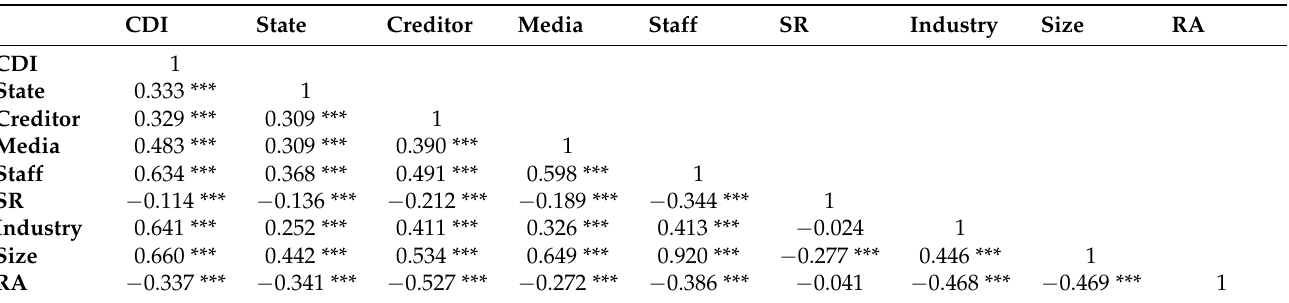
Table 4. Variable correlation coefficient matrix.